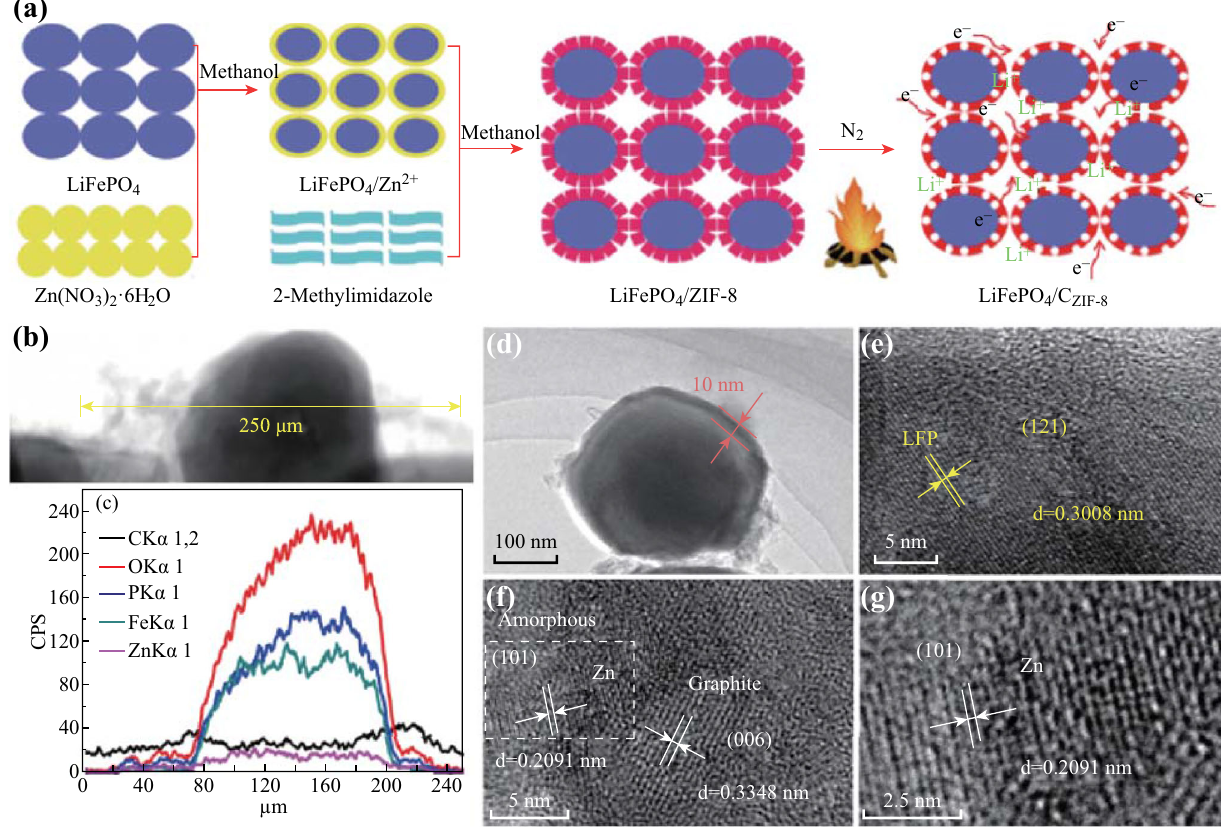
Fig. 1 a Schematic illustration of the synthesis process. b TEM image, c line scanning EDS, d surface coating layer structure of LFP/C ZIF-8 . Regular lattice fringes of e LFP, f graphite and g Zn